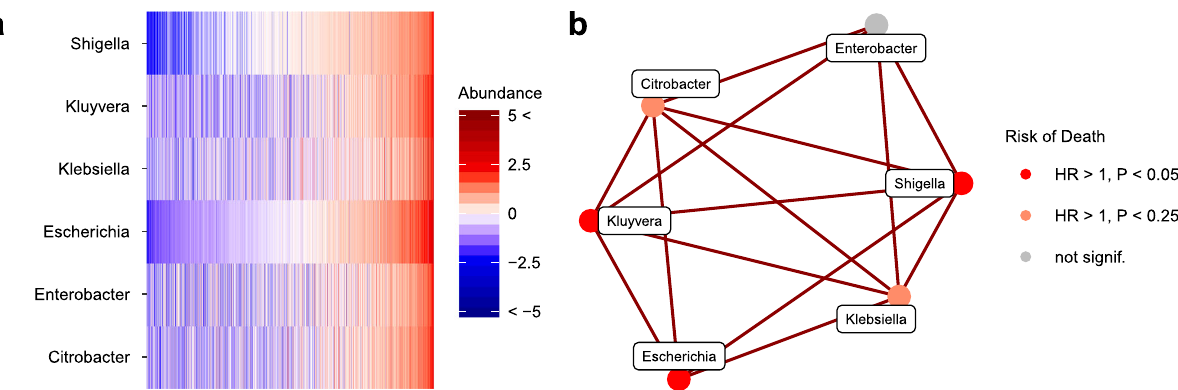
Fig. 4 Taxonomic subnetwork associated with increased mortality risk. a Abundance variation across the study population for the subnetwork that exhibits the strongest mortality associations (CLR-transformed abundances centred at zero and scaled to unit variance). The samples are ordered by the total relative abundance of the subnetwork. b The observed subnetwork structure and mortality risk. The total subnetwork abundance was associated with elevated mortality with a hazard ratio of 1.155 (95% con fi dence interval [CI], 1.08 – 1.24; P = 0.0002, Wald two-tailed test statistic for Cox regression,